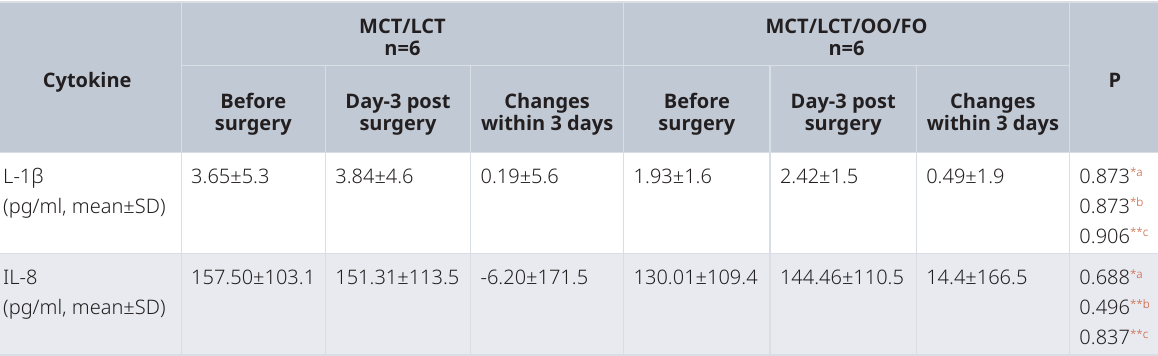
Table 3. Cytokine levels in subjects.